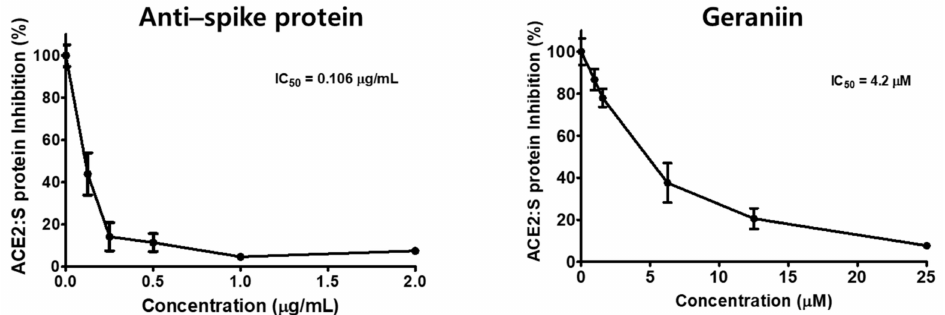
Figure 1. Inhibitory effect of geraniin on the binding of spike protein receptor-binding domain (RBD) to the human angiotensin-converting enzyme 2 (hACE2) receptor. Spike protein coated on a 96-well plate interacted with a pre-incubated mixture of the ACE2 receptor and 0, 0.78125, 1.5625, 6.25, 12.5, or 25 µ M geraniin. The spike protein antibody was used as the positive control. The inhibition of the binding of the spike protein to the hACE2 receptor by geraniin was evaluated by measuring